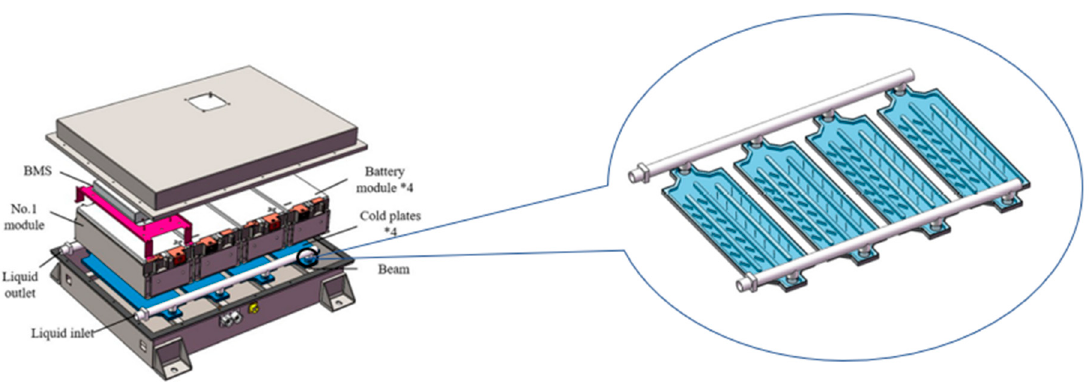
Figure 3. Position structure diagram of fin-liquid cooling plate [33]. Reproduced from reference [33], with permission from AIP, copyright 2020.